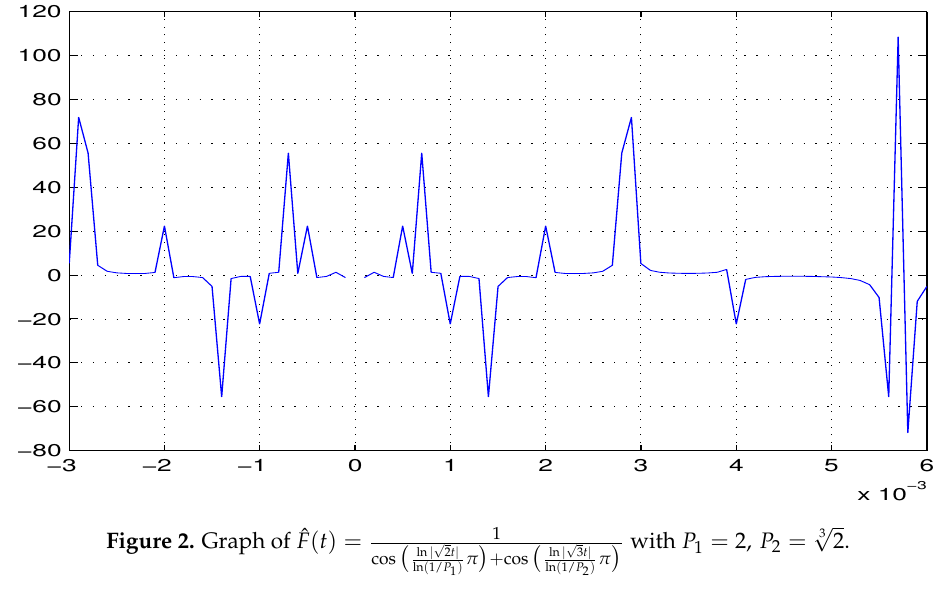
Figure 2. Graph of ˆ F ( t ) = 1